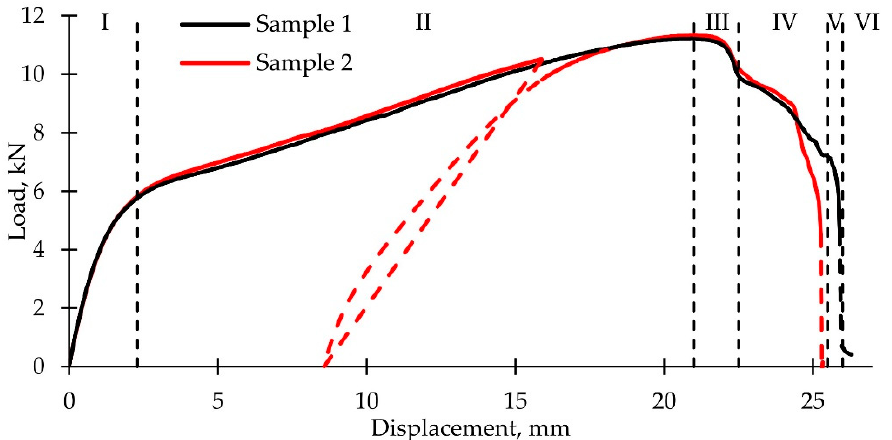
Figure 2. Loading diagrams with the noted stages: I, elastic; II, linear hardening up to maximum load; III, initial postcritical deformation with the neck occurring; IV, stabilization of postcritical deformation with neck development; V, intensive softening, which leads to the nonequilibrium damage accumulation; VI, final sample separation.